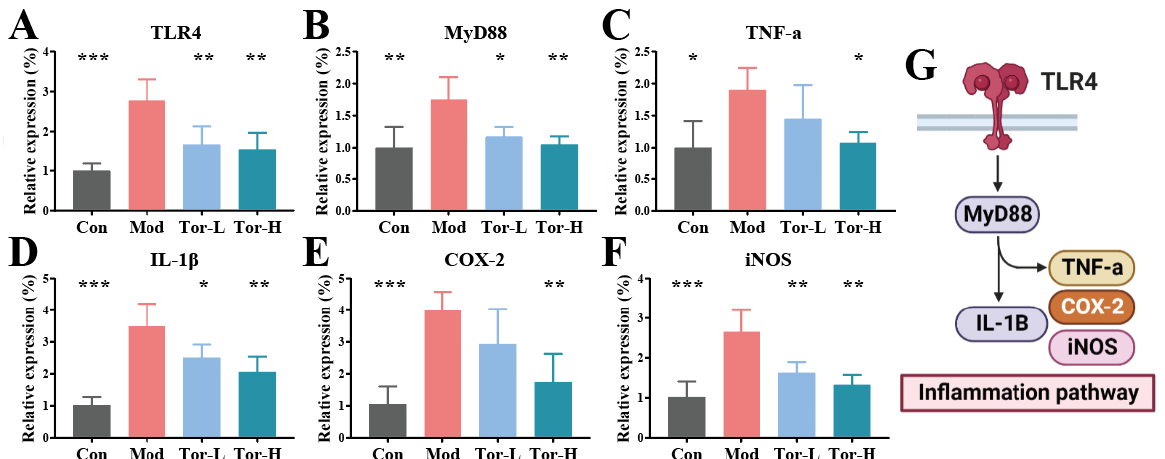
Figure 4. Effect of torularhodin on the RAW 264.7 inflammatory cell model. ( A ) Relative expression levels of TLR4. ( B ) Relative expression levels of MyD88. ( C ) Relative expression levels of TNF-a. ( D ) Relative expression levels of IL-1 β . ( E ) Relative expression levels of COX-2. ( F ) Relative expression levels of iNOS. ( G ) TLR4 inflammatory pathway. Significant differences between Mod group and other groups: * p < 0.05, ** p < 0.01, *** p < 0.001.